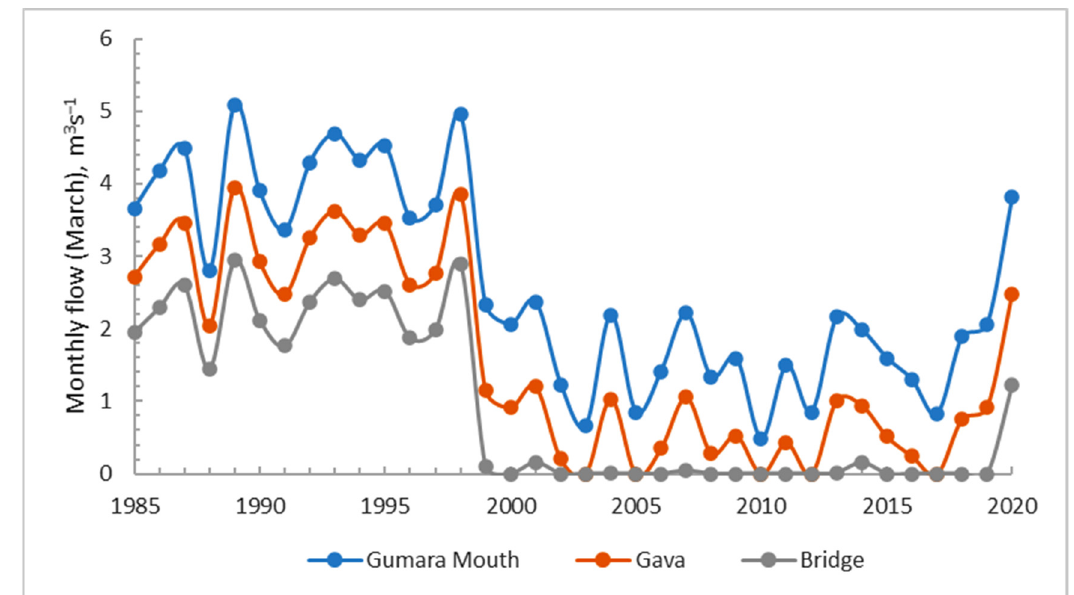
Figure 2. Monthly flow of March for the three sites of Gumara River between 1985 and 2020. The Gumara mouth (blue) and Gava (orange) are modelled flows where irrigation water of 2.987 m 3 s − 1 was subtracted, and Bridge (grey) is observed flow.